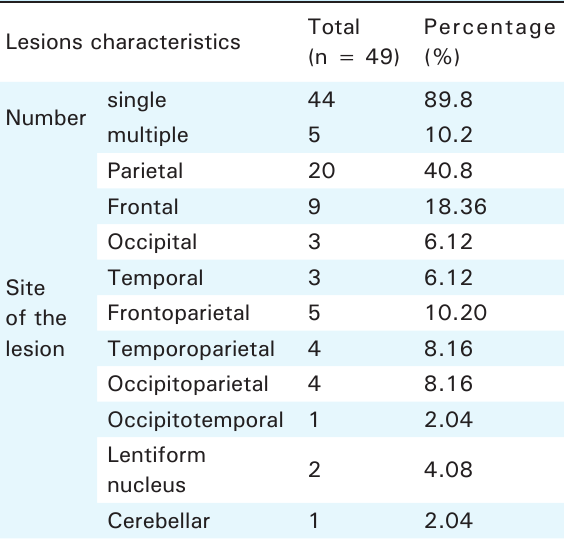
Table 3. CT scan findings at presentation in children with neurocysticercosis.